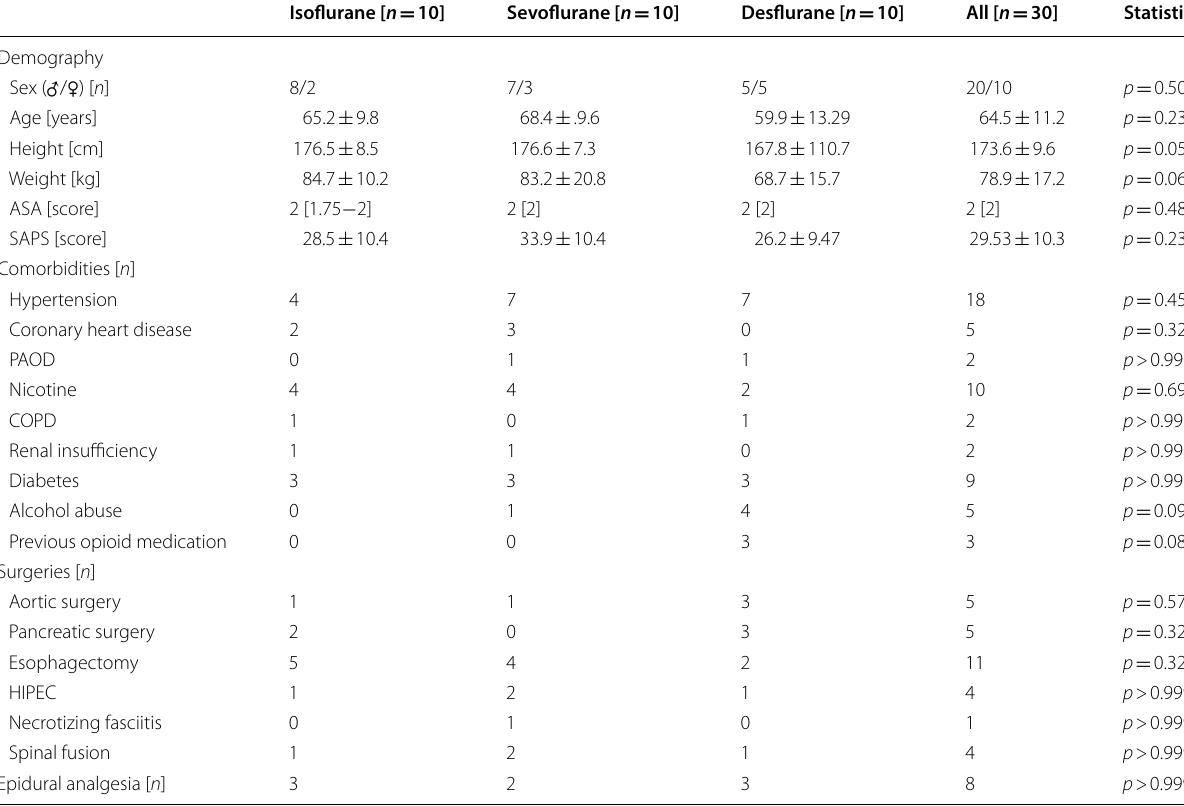
Table 1 Patient